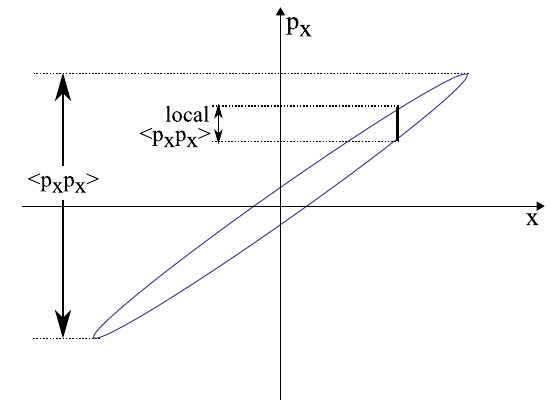
FIG. 1. The local momentum (cid:1) matrix describes the distribu- tion of momentum in a small spatial element of the